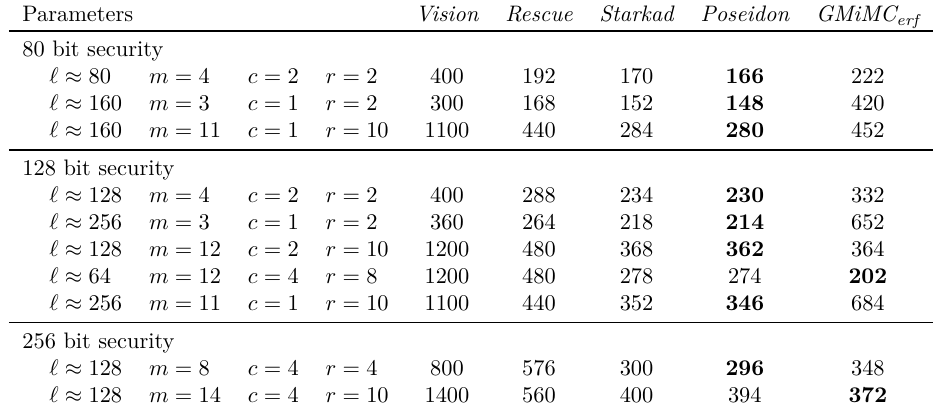
Table 3: Comparison of Vision , Rescue , Starkad , Poseidon , and GMiMC erf over R1CS where ‘, c , and r are as in the case of Table 2. The efficiency is given by the overall number of